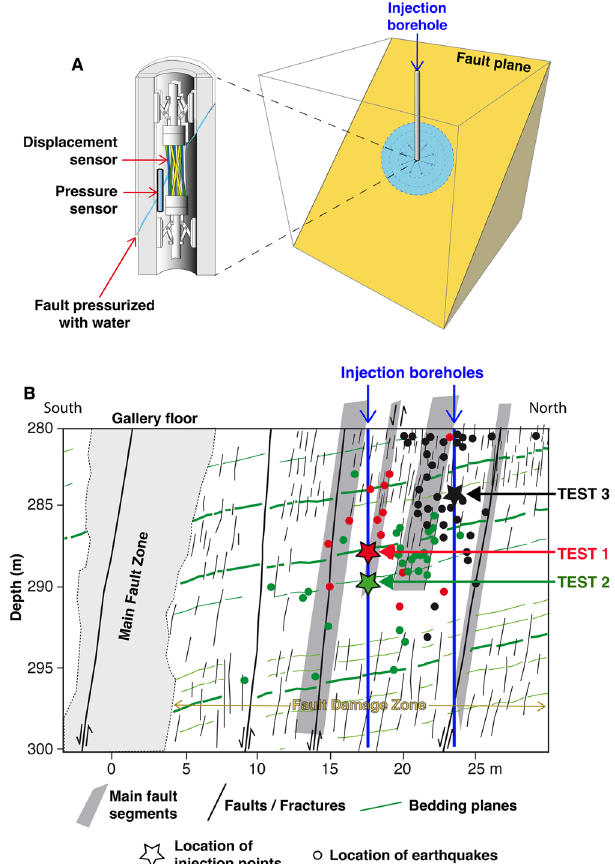
Fig. 1 Experimental context. A Set-up for a typical fl uid injection test that measures fl uid pressure and displacement in the fault plane with a SIMFIP probe 22 in borehole. B Locations of the injection tests (red star for Test 1, green star for Test 2, and black star for Test 3) and seismic events (colored dots, different for each test) in the fault zone at 280 m depth within the Low Noise Underground Laboratory in France (modi fi ed from 21 ). The gallery fl oor corresponds to the top of the